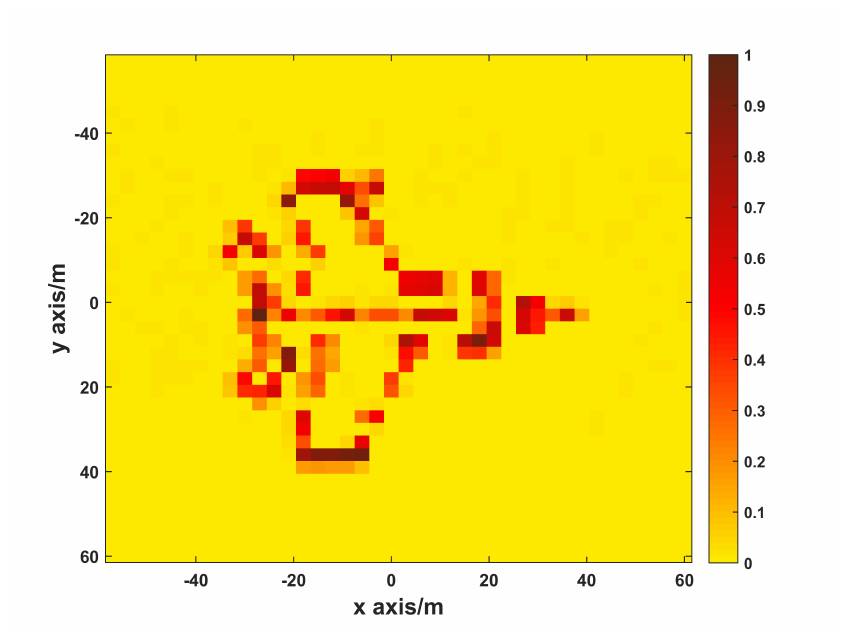
Figure 4. Target image.